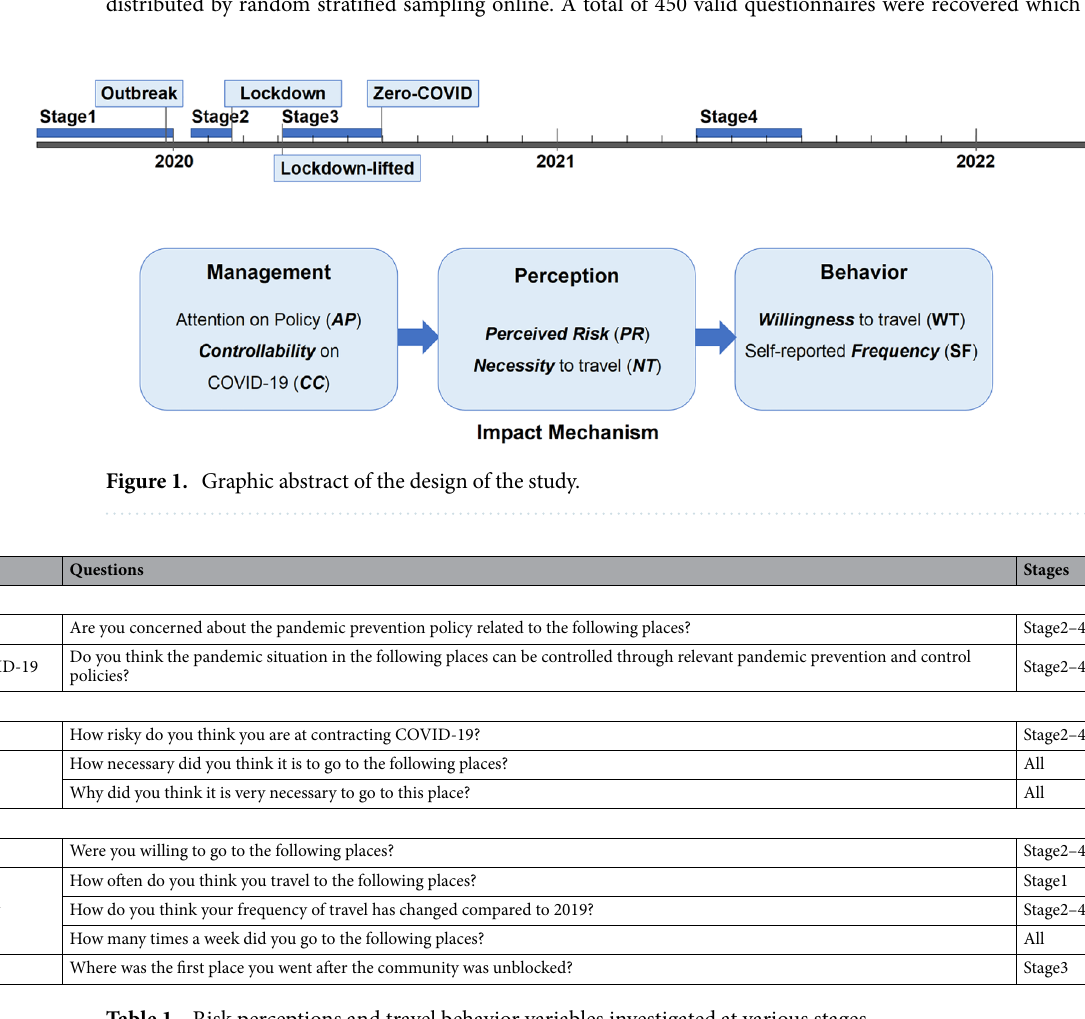
Table 1. Risk perceptions and travel behavior variables investigated at various